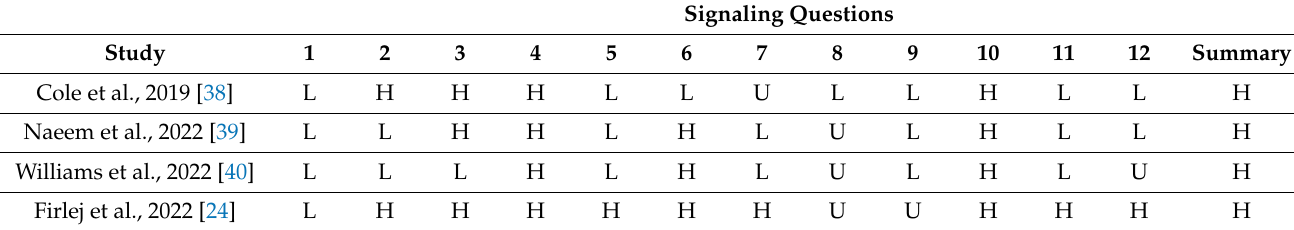
Table 2. Risk of bias assessment for in vitro studies using the Quin tool. 1: Clearly stated aims/objects;